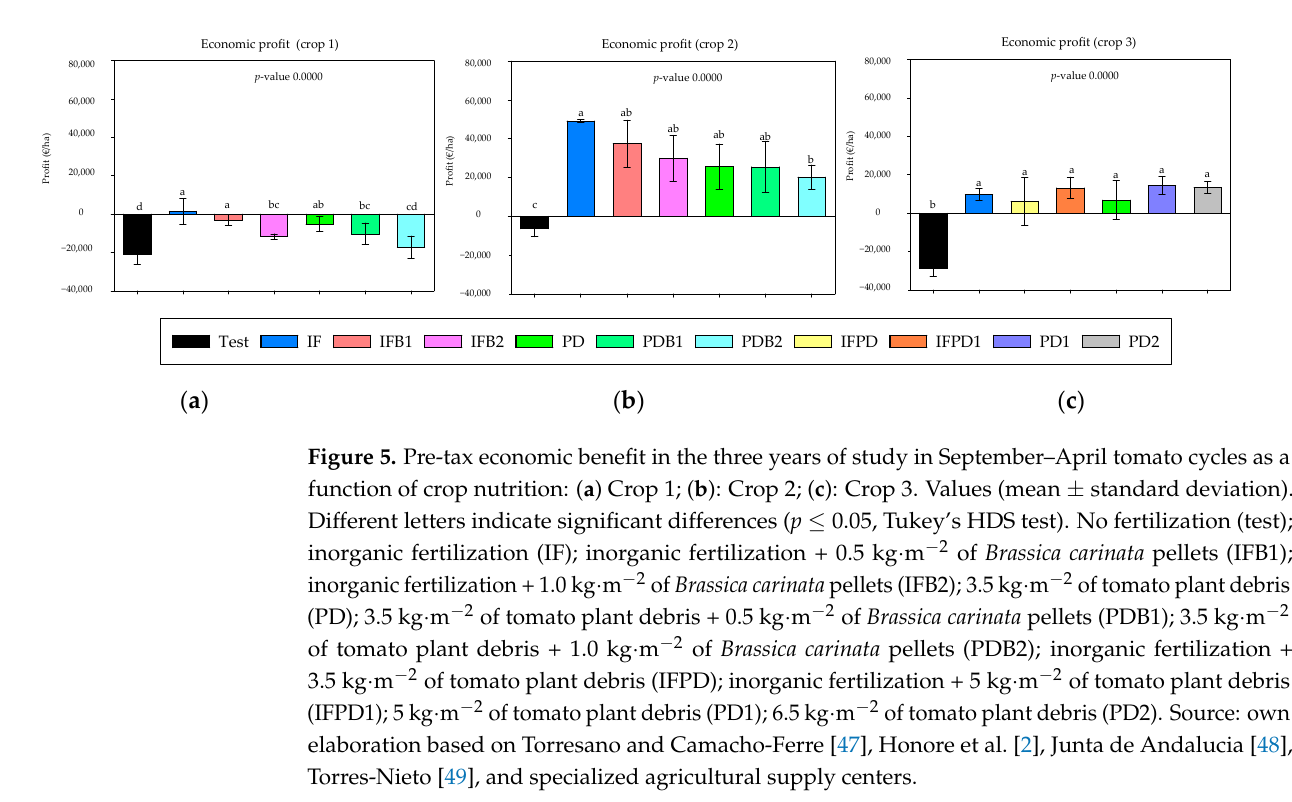
Alternative Alternative Alternative 1 (%) 2 (%) 3 (%)